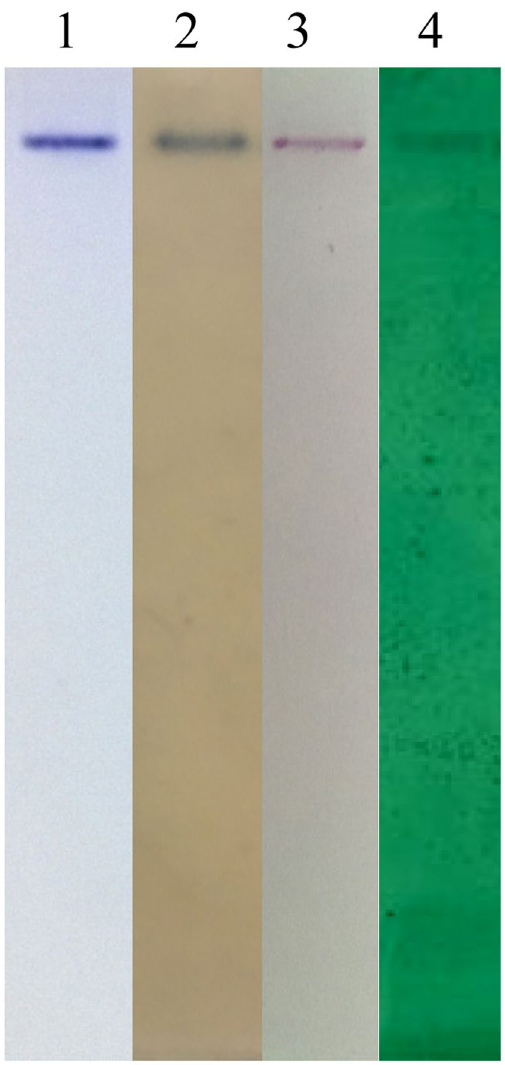
Figure 4. Specific staining of carbohydrate (lane 2), phosphorus (lane 3) and lipid components (lane 4) for the purified protein. Lane 1 was stained with